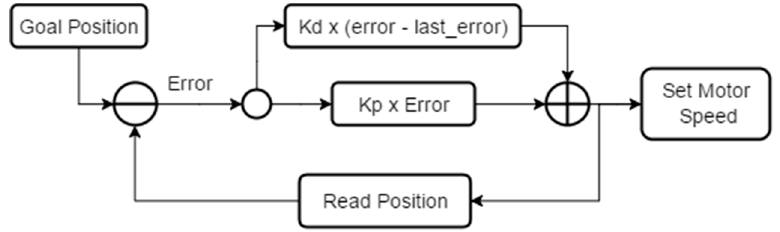
Figure 7. Motor velocity control loop.